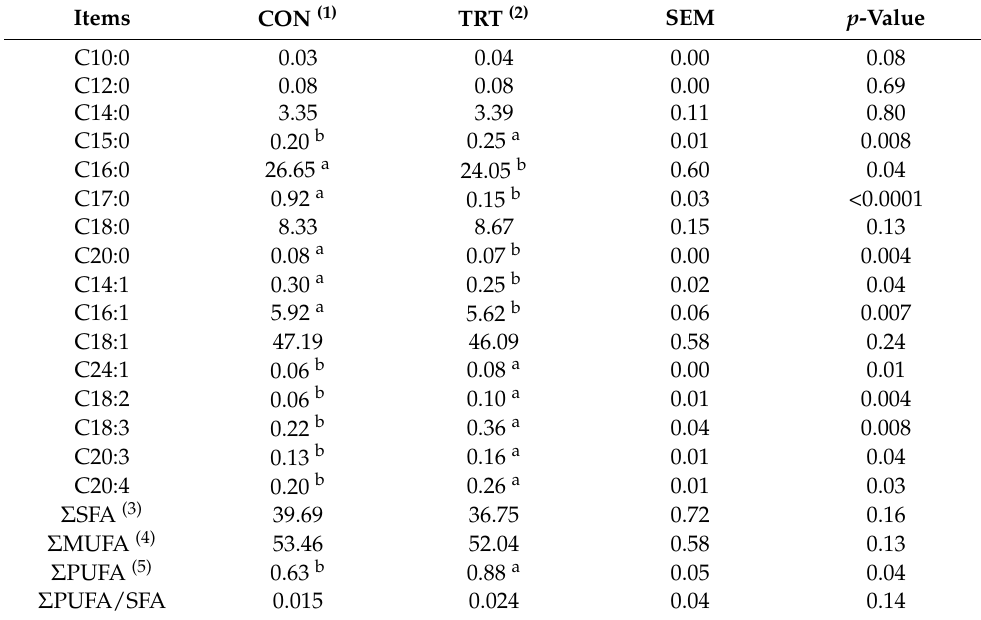
Figure 2. Effect of stevioside and organic selenium on the TBARS values in meats of Hanwoo cattle. Data presented as the mean ± s.e. bars at a specific time point with different letters show a significant difference ( p < 0.05). Table 6. Fatty acid profile of Longissimus dorsi muscle from Hanwoo cattle fed diets containing stevioside and organic